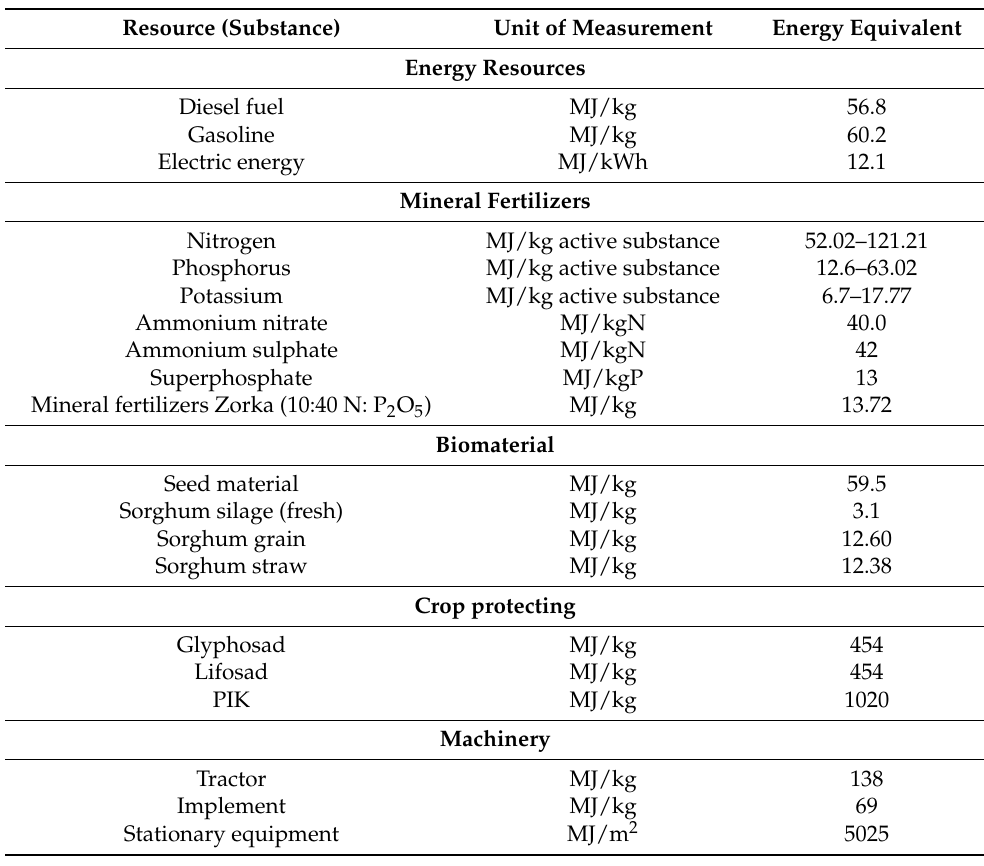
Table 3. Energy equivalents of basic technological